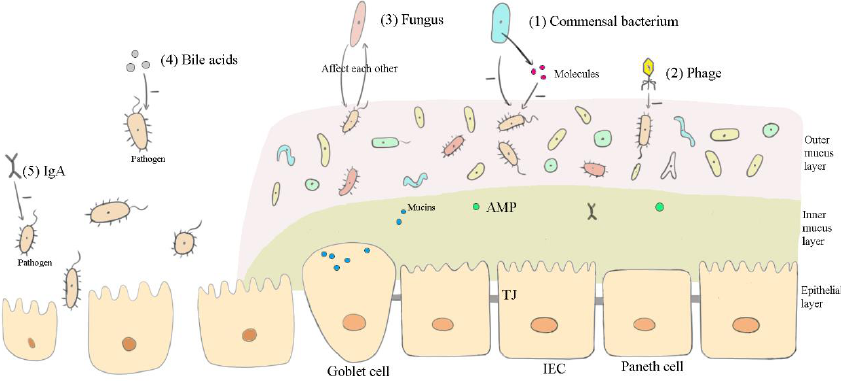
Figure 1. How the important components in FMT affect the microbiota of the recipient’s intestines. “+” represents promotional effects, while “-” represents suppressive effects. (1) Commensal bacteria from donor feces compete with pathogenetic bacteria for resources to inhibit their growth. Commensal bacteria also secrete molecules (such as bacteriocins) to directly impact pathogenic bacteria. (2) Phages, through lysing bacteria or modifying bacterial structures, kill bacteria or alter their virulence. (3) Fungal microflora and bacterial microflora in the intestine impact one another. (4) Bile acids promote the growth of bile acid-metabolizing bacteria and inhibit the growth of other bile-sensitive bacteria. (5) Immunoglobulin A (IgA), as the first line of defense, suppresses pathogens and their toxins in the gut.